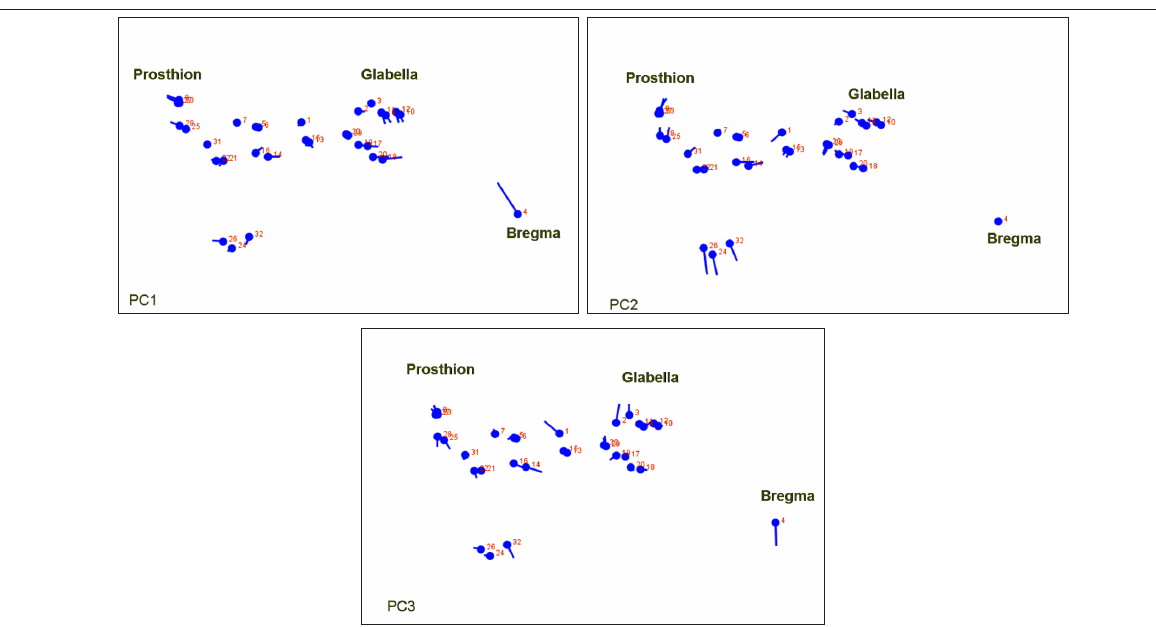
7 South African Journal of Science